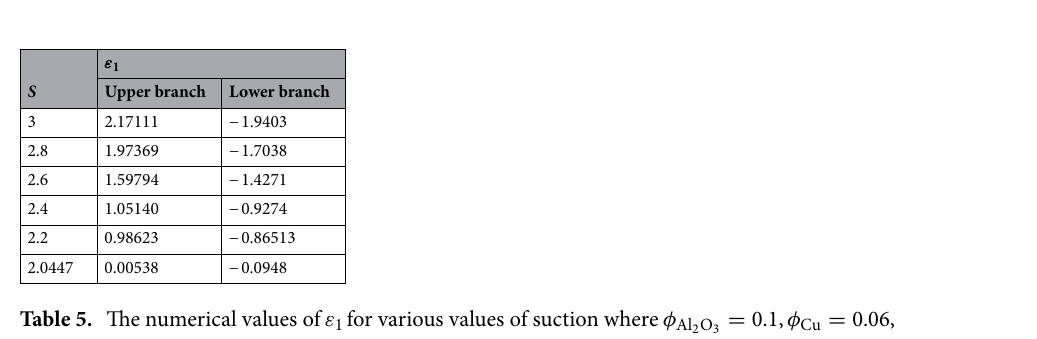
Table 5. The numerical values of ε 1 for various values of suction where φ Al 2 O 3 = 0.1, φ Cu = 0.06, (cid:31) 0.2, Rd 0.2, δ 0.1 δ T 1 = − = = =